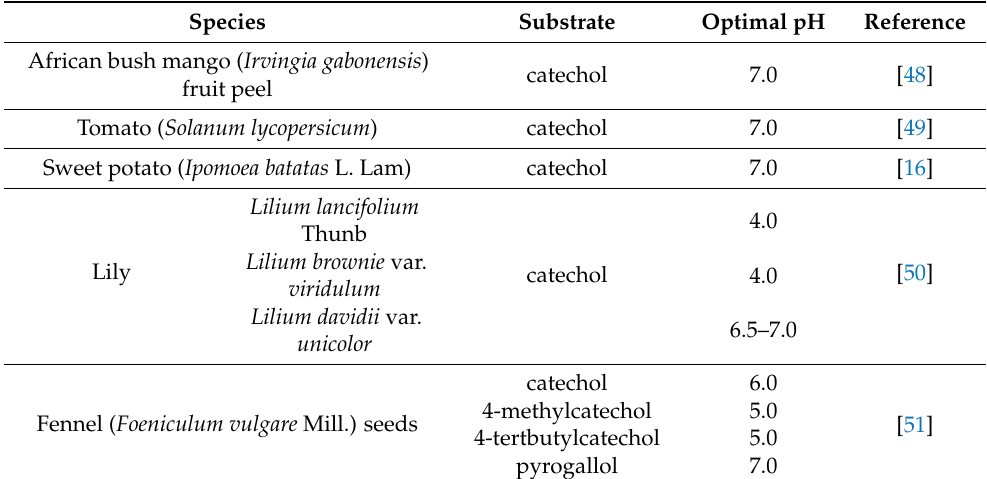
Table 1. Optimum pH of PPO in different